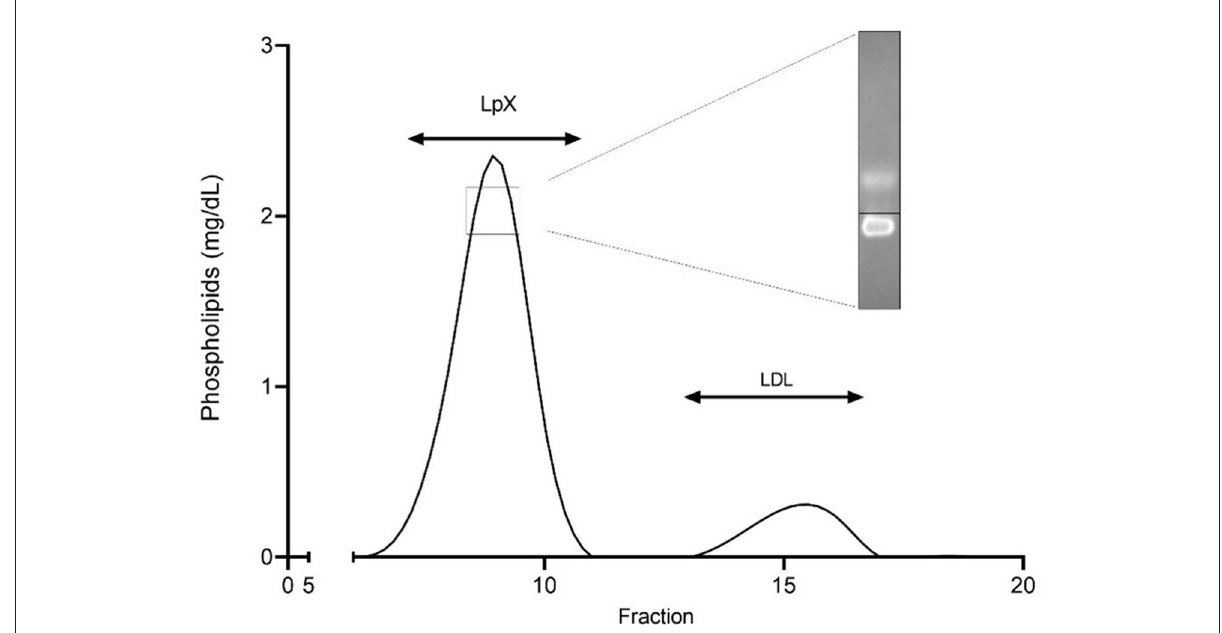
FIGURE3 Separation of the 1.020–1.063 g/ml plasma fraction by fast protein liquid chromatography (FPLC). The 1.020–1.063 g/ml density fraction, corresponding to lipoprotein X and LDL, was separated by FPLC and analyzed for phospholipid content. Insert shows cathodic migration of Lp X stained with filipin at agarose gel electrophoresis. Black line indicates